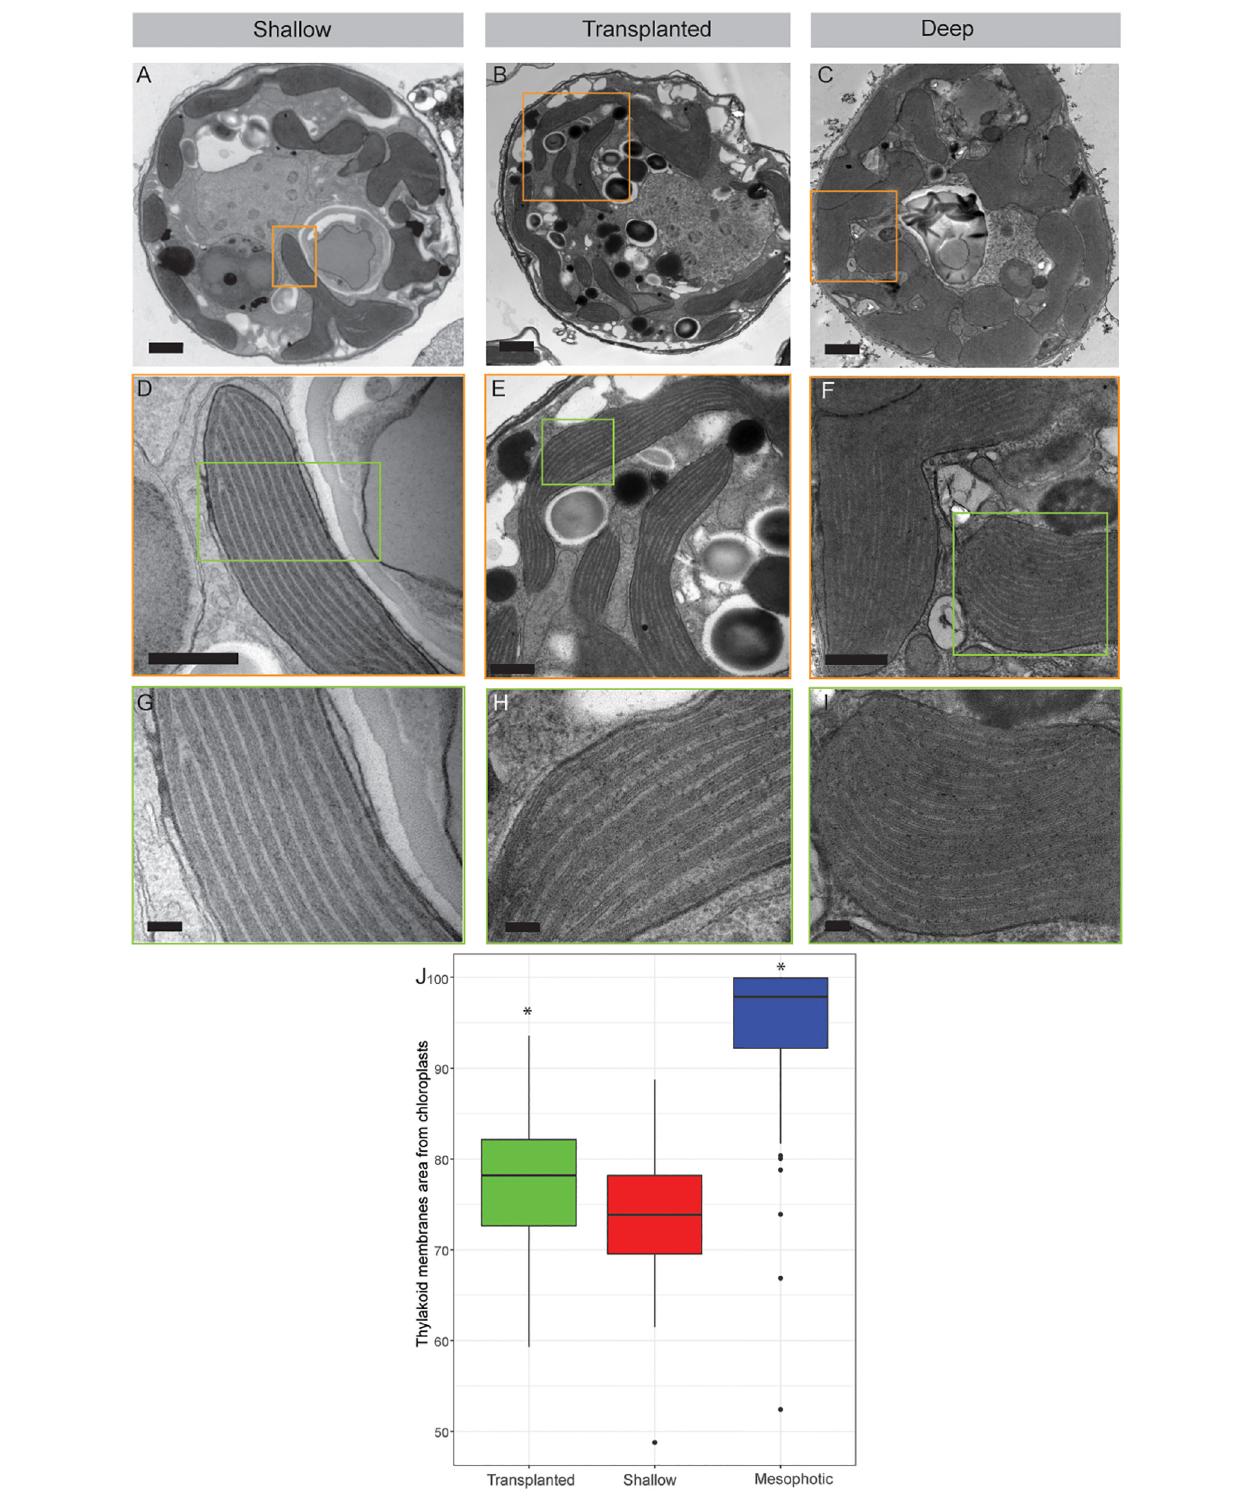
FIGURE 3 | Transmission electron microscopy of symbiont cells. (A–C) Whole cell view of the symbiont cells from shallow, transplanted and mesophotic colonies. (D–F) High magnification of the chloroplasts delimited by the orange box in (A–C) . (G–I) High magnification of the thylakoid membranes view delimited by the green box in (D–F) . (J) The thylakoid membranes area from chloroplasts is 74 ± 7% in shallow corals, 78 ± 7% in transplanted corals and 95 ± 8% in mesophotic corals. Scale bars: 1 µ m (A–C) , 500 nm (D–F) , 100 nm (G–I) . Asterisks (*) indicate statistical differences relative to shallow colonies.